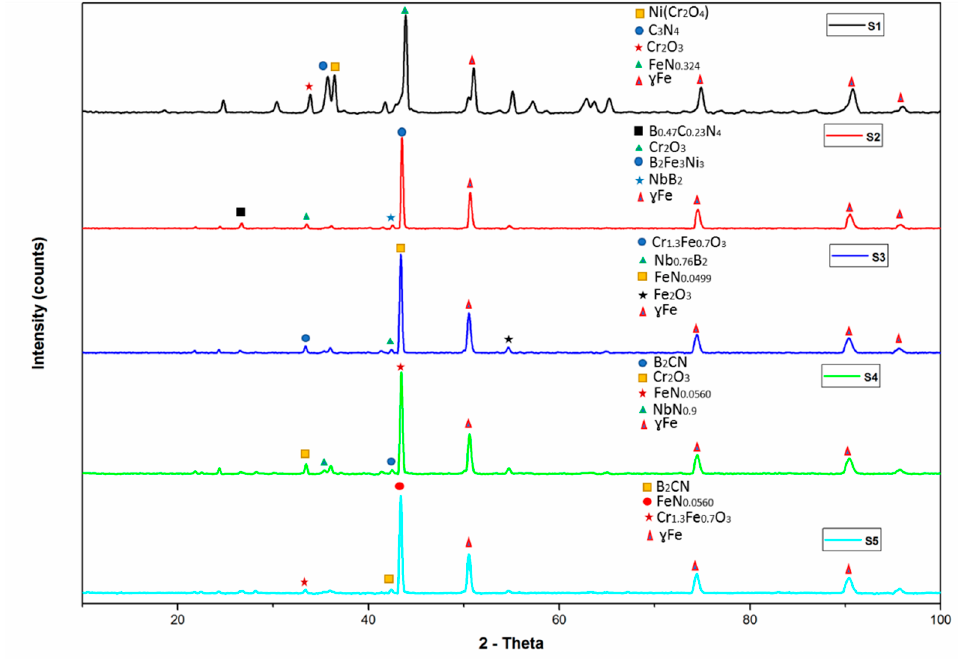
Figure 5. XRD spectra of all sintered samples.